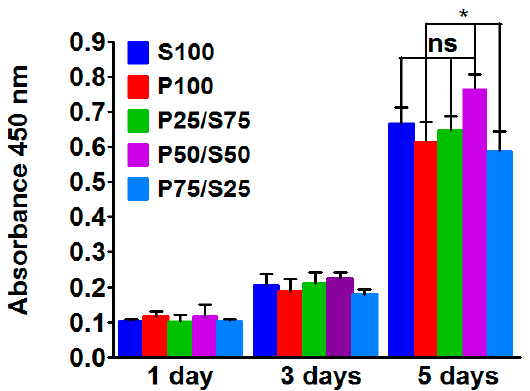
Figure 5. CCK-8 assay after culturing rat ear chondrocytes on hydrogels for 1, 3 and 5 days. Significant differences are presented as * p < 0.05, and ns indicates not significant.